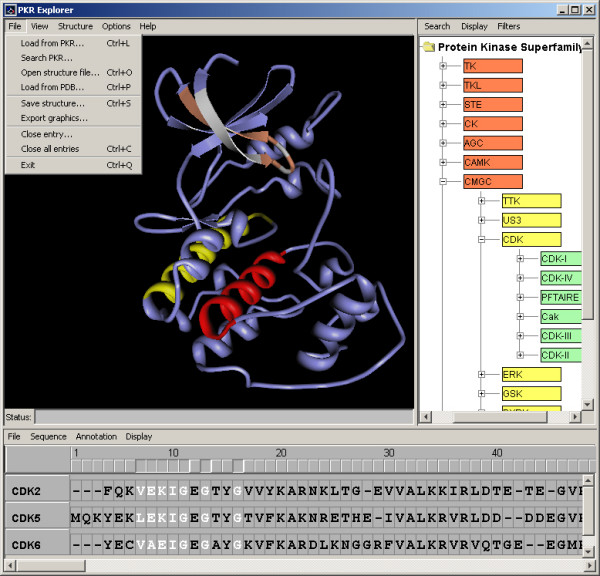
Protein kinase explorer. An alternative view of a cAMP dependant protein kinase with residues from the multiple structure alignment mapped to the corresponding aligned sequences and to a single template structure from the set.